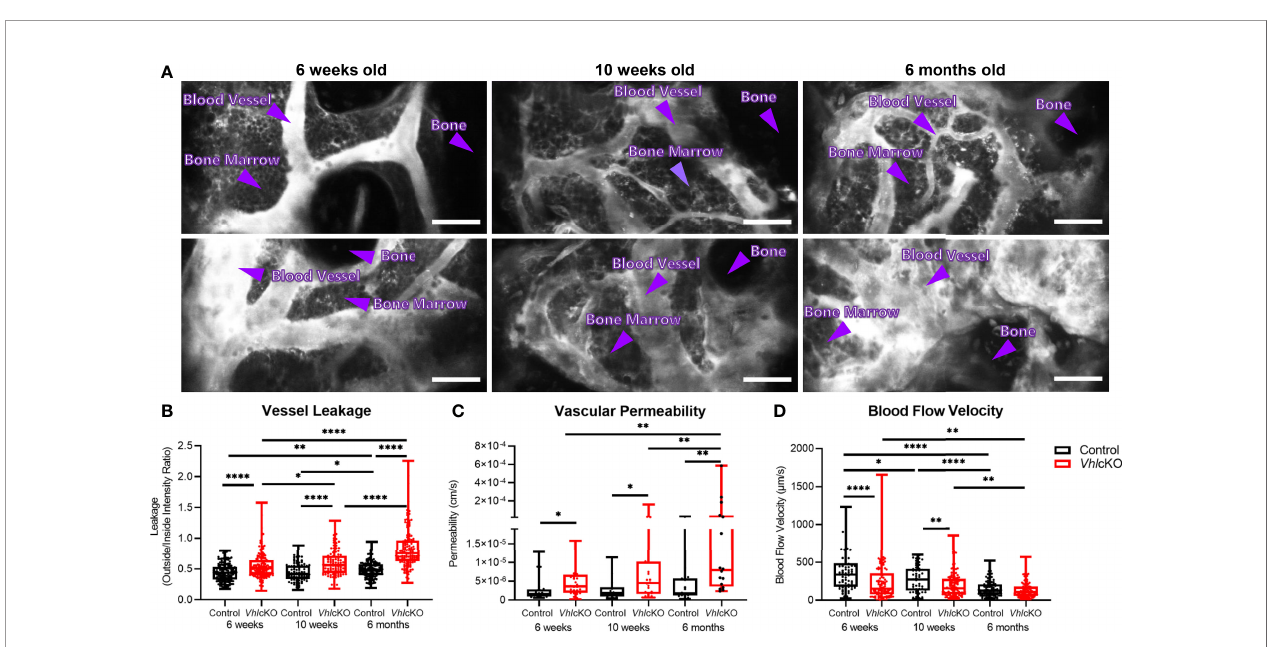
FIGURE 7 | Disruption in blood-bone marrow barrier revealed by intravital microscopy. Blood vessel microenvironment comparisons of control and Vhl cKO mice at 6- week (n=4), 10-week (n=4) and 6-month (n=5) timepoints. (A) Representative contrast adjusted max intensity projections of the calvarial BM in control and Vhl cKO mice by age; White: blood vessel (Rhodamine B Dextran, 70 kDa); scale bar: 50 m m; quanti fi cation of calvarial BM (B) blood vessel leakage, (C) vascular permeability, and (D) blood fl ow velocity. *p<0.05, **p<0.01, ****p<0.0001, Mann-Whitney